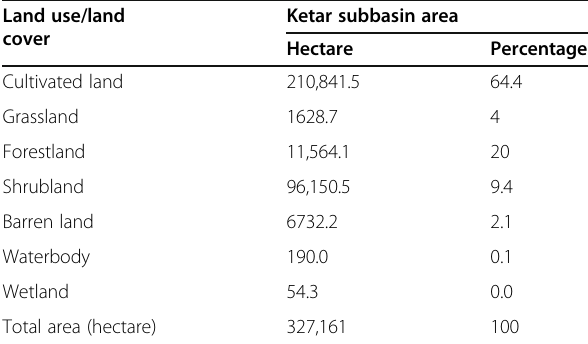
Table 2 Land use and land cover data of Ketar subbasin in